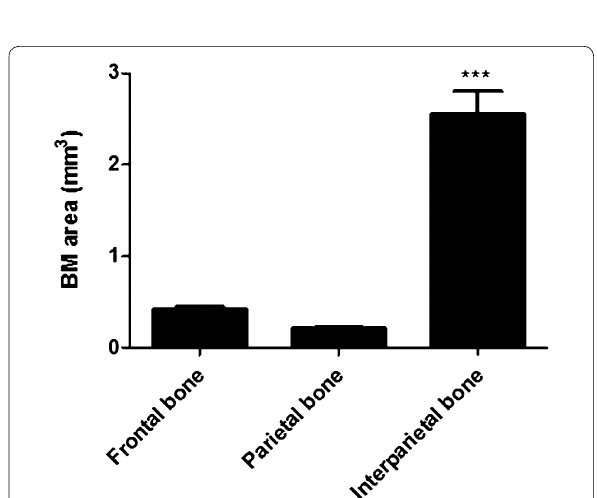
Fig. 2 Analysis of BM areas in calvarial bones of male C57BL/KalwRi‑ JHsD mice. There was a significant increase in the BM volume in interparietal bones compared to frontal and parietal